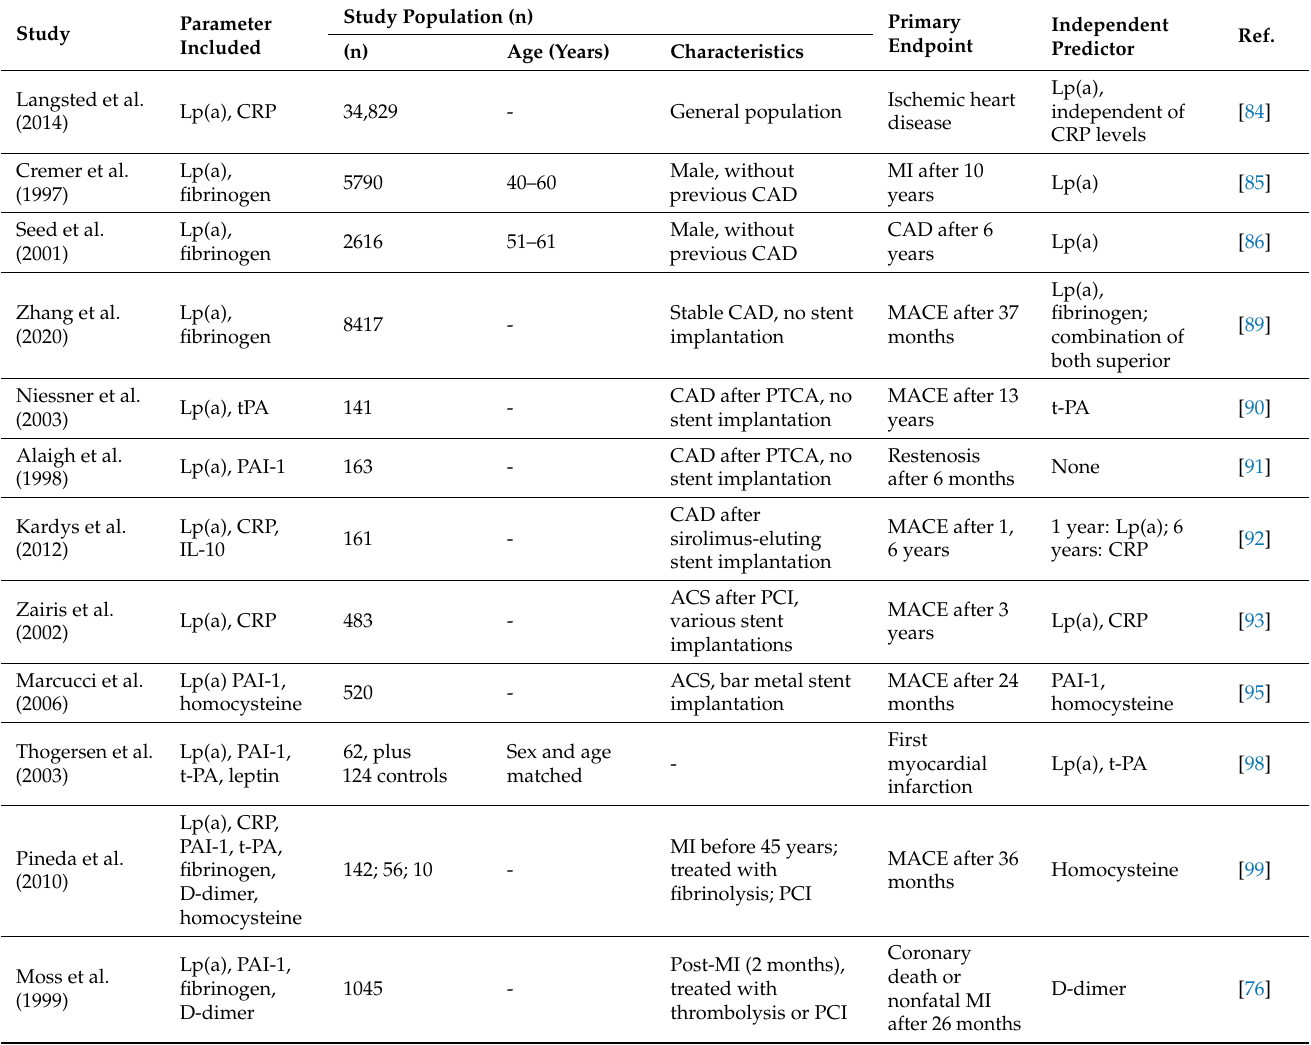
Table 1. Overview of prospective studies that have examined Lp(a) and at least one inflammatory and/or fibrinolytic